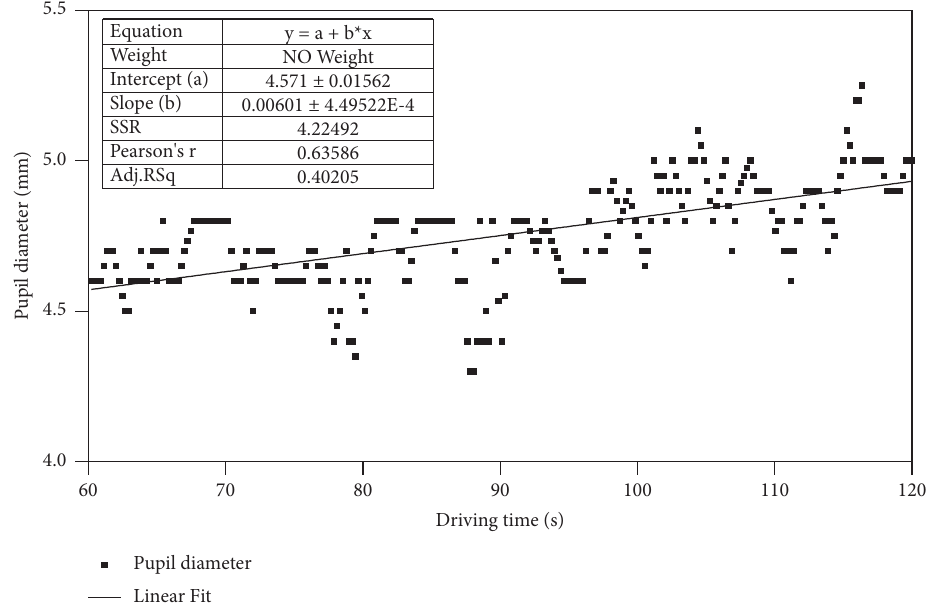
Figure 7: Drivers’ pupil diameter changes during 60th to 120th second of driving in Qinling tunnel.